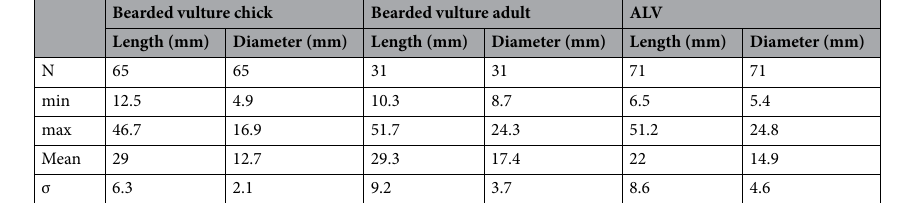
Table 1. Measures (maximum length and diameter, in mm) of bearded vulture scats (chicks and adults) and ALV coprolites.